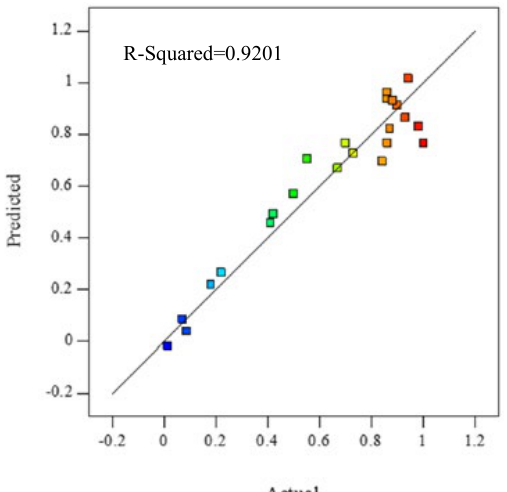
R-Squared=0.9201